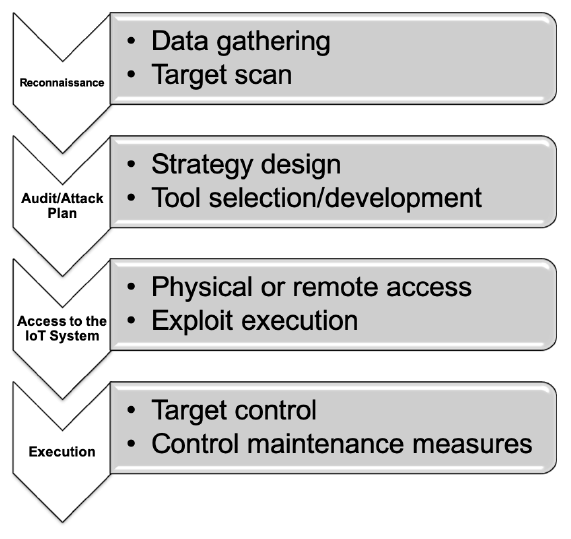
Figure 4. IoT device audit/attack